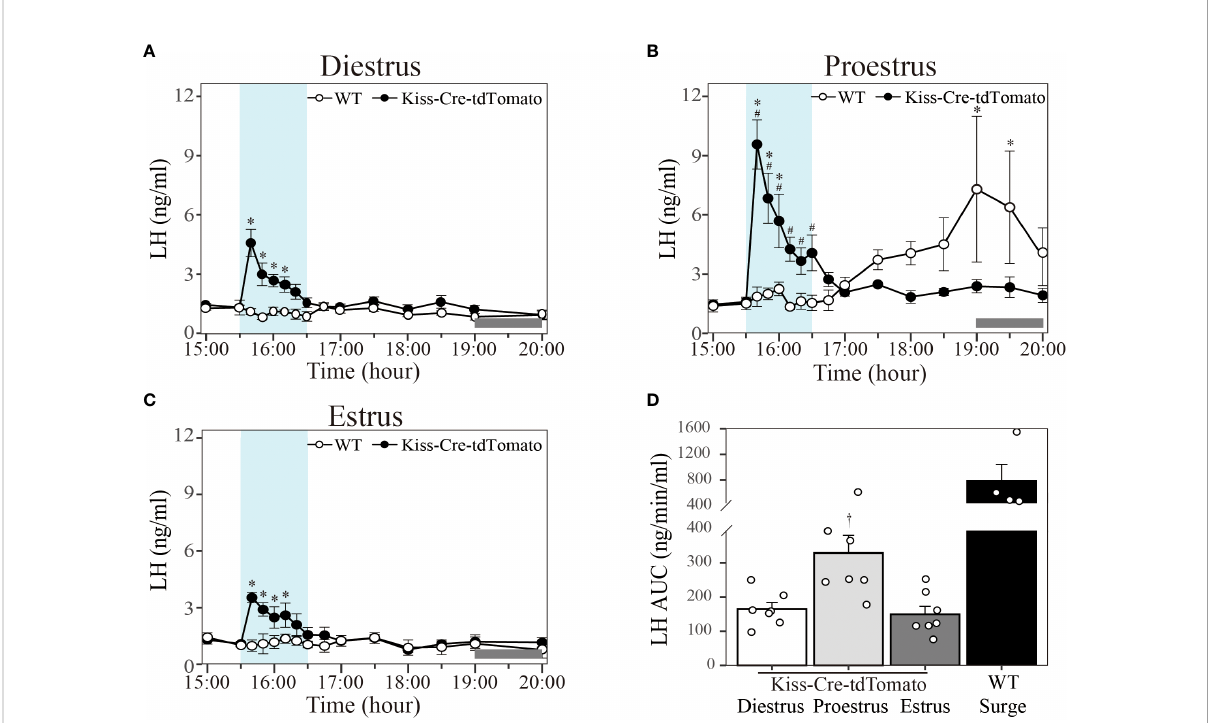
FIGURE 4 Effect of 20 Hz optical stimulation of Kiss1 ARC neuron terminals in the AVPV on LH secretion in different stage of the estrous cycle. Circulating levels of LH (Mean ± SEM) in response to: (A) 1-h optic stimulation (15:30 – 16:30 h) in diestrous Kiss-Cre-tdTomato (black circle) and wild type (white circle) mice, (B) 1-h optic stimulation (15:30 – 16:30 h) in proestrous Kiss-Cre-tdTomato (black circle) and wild type (white circle) mice and (C) 1-h optic stimulation (15:30 – 16:30 h) in estrous Kiss-Cre-tdTomato (black circle) and wild type (white circle) mice. (D) The AUC for LH secretion during a 1-h optic stimulation (15:30 – 16:30 h) at 20 Hz in diestrous, proestrous and estrous Kiss-Cre-tdTomato mice. Individual data points were shown as black circles. AUC for the spontaneous LH surge (17:30 – 20:00 h) in WT mice is also indicated in (D) . Grey bar on abscissa represents the light-off. *P < 0.05 relative to baseline LH levels at 15:00 h (-30 min). # P < 0.05 represents LH levels in proestrous group relative to mean LH levels in diestrous and estrous at the same time point. † P < 0.05 relative to LH AUC for diestrus and estrus. Kiss-Cre- tdTomato, n = 7 per treatment group. Wildtype, n = 4 per treatment